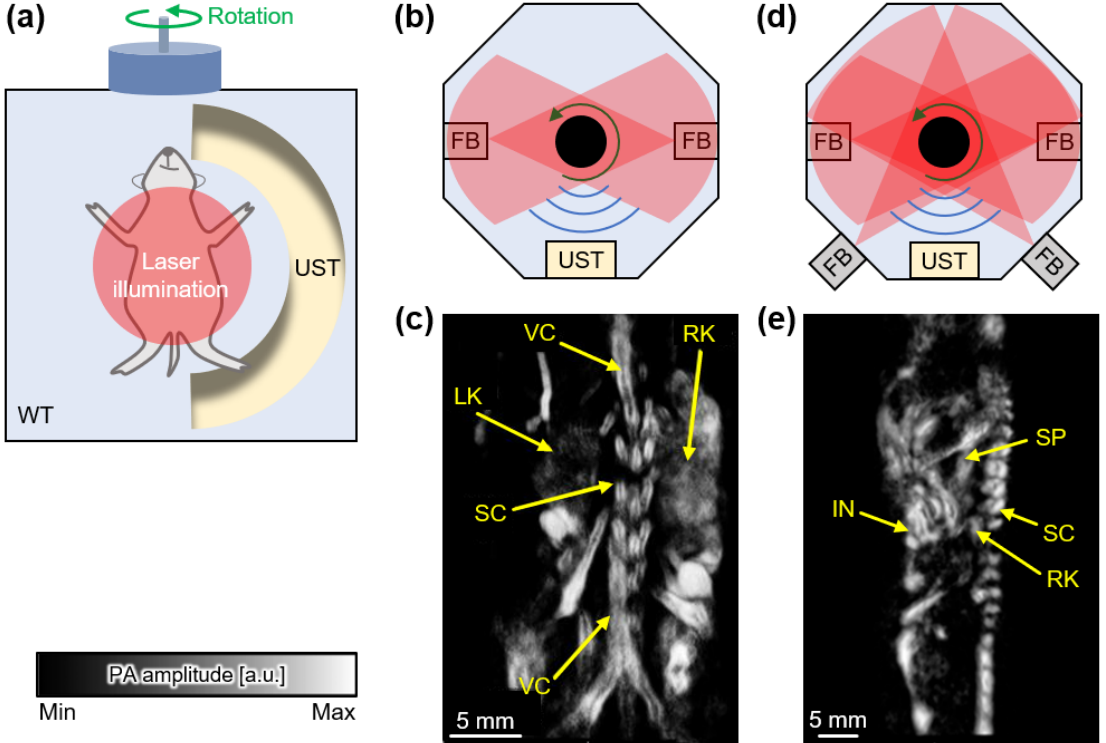
Figure 3. PAI systems with curved array USTs. ( a ) Schematic of PAI system with a rotational